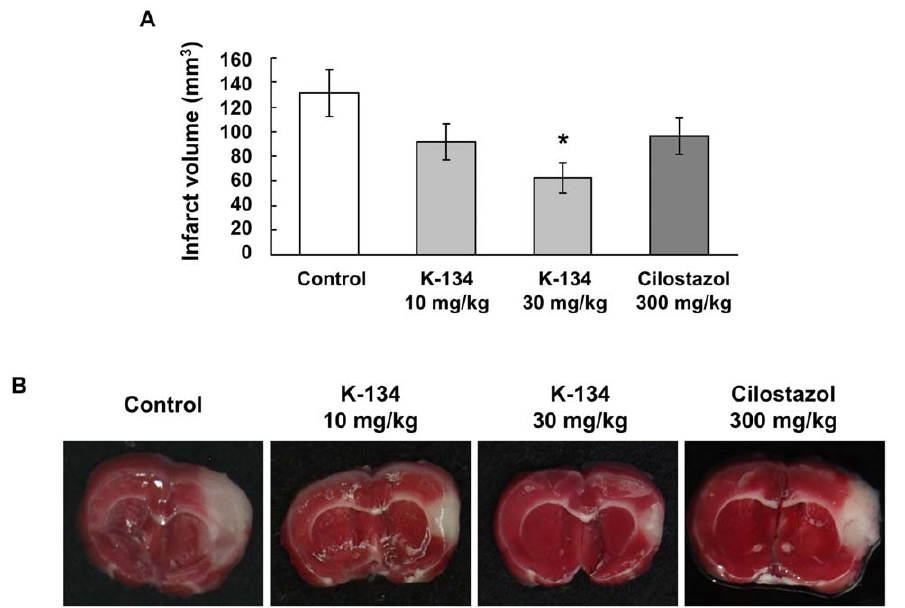
Figure 2. Inhibitory effects of K-134 on infarction volume in a photothrombotic cerebral infarction model. Preadministration of K-134 but not cilostazol significantly and reduced cerebral infarction volume in a photothrombotic cerebral infarction model in comparison with vehicle- treated controls ( A ). Values are means 6 SEM (* P , 0.05, two-tailed Dunnett’s test, n =12). ( B ) Representative photographs (1.35 cm 6 1.65 cm) show TTC-stained brain sections sliced at the location of bregma. The white-colored area represents the infarct region. Data shown are representative of two experiments with similar results.